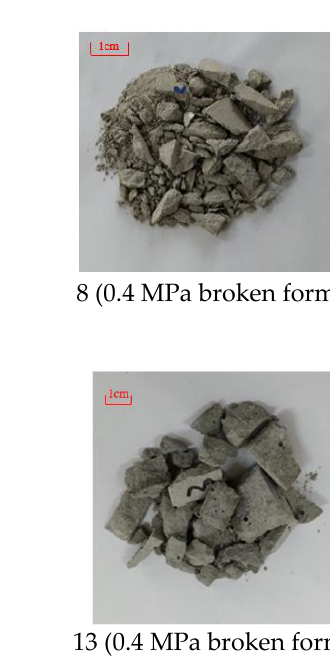
Figure 8. Relationship between dynamic strength and strain rate of similar materials.